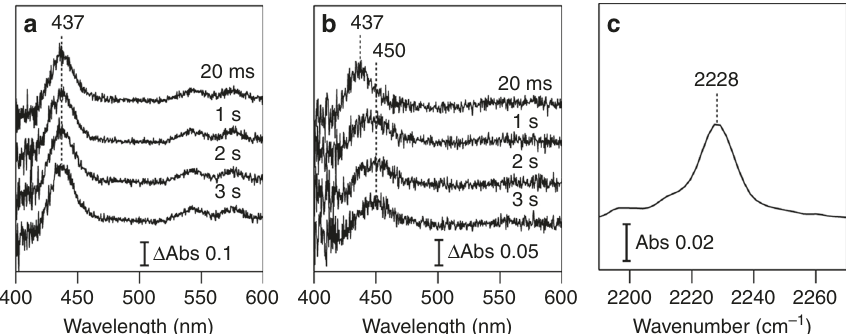
Fig. 3 Crystal spectroscopy of ferric P450nor. TR-visible absorption difference spectra of a MC-1 and b MC-2 after caged-NO photolysis. The difference was calculated by subtracting the spectrum recorded prior to photolysis. c Static IR spectrum of MC-2 after caged-NO photolysis. All the measurements were performed in the presence of the SFX carrying medium (hydroxyethyl cellulose matrix) at 293 K